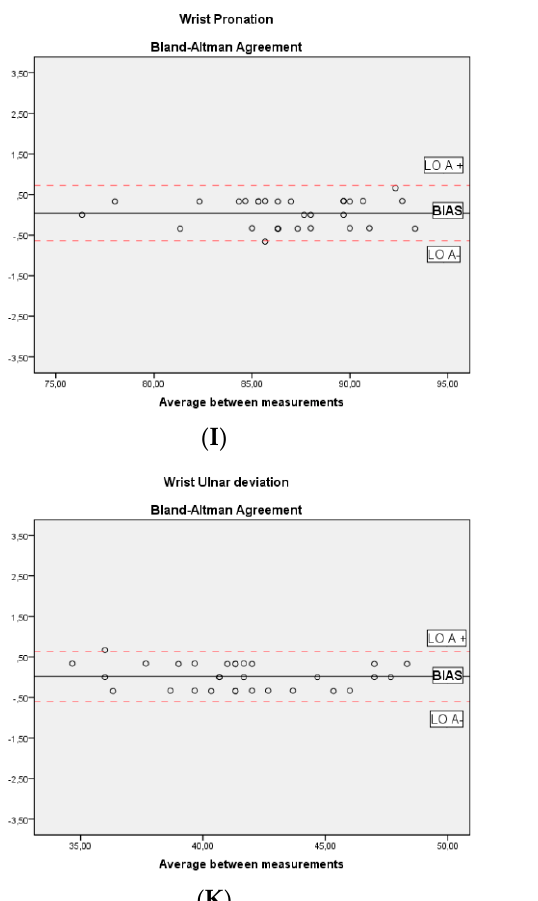
Table 2. Validity between Veloflex-IDA and goniometer to measure the range of motion of the upper limb joints.